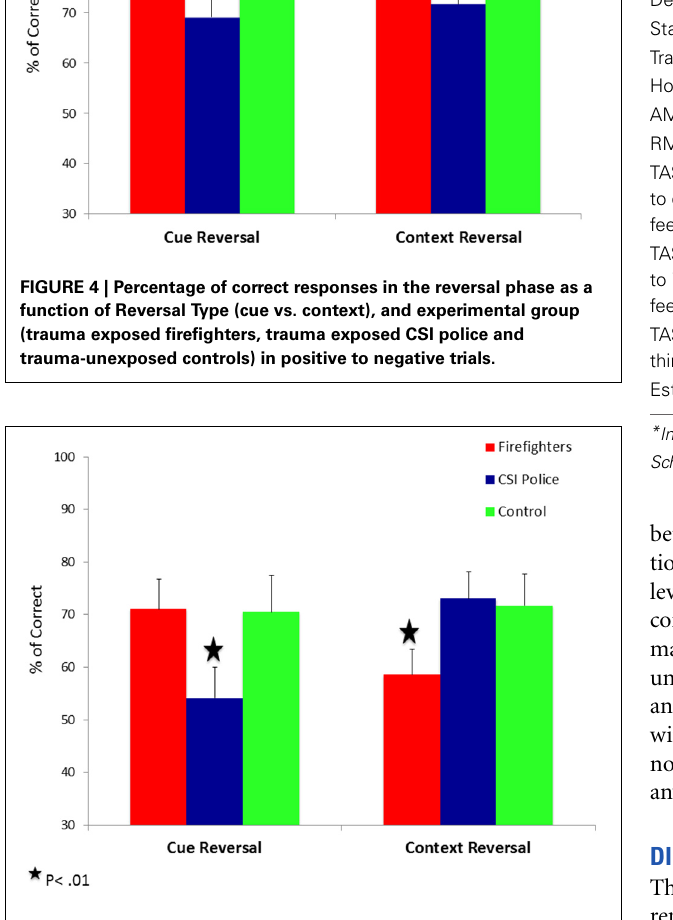
FIGURE 5 | Percentage of correct responses in the reversal phase as a function of Reversal Type (cue vs. context), and Experimental Group (trauma exposed firefighters, trauma exposed CSI police and trauma-unexposed controls) in negative to positive reversal trials.